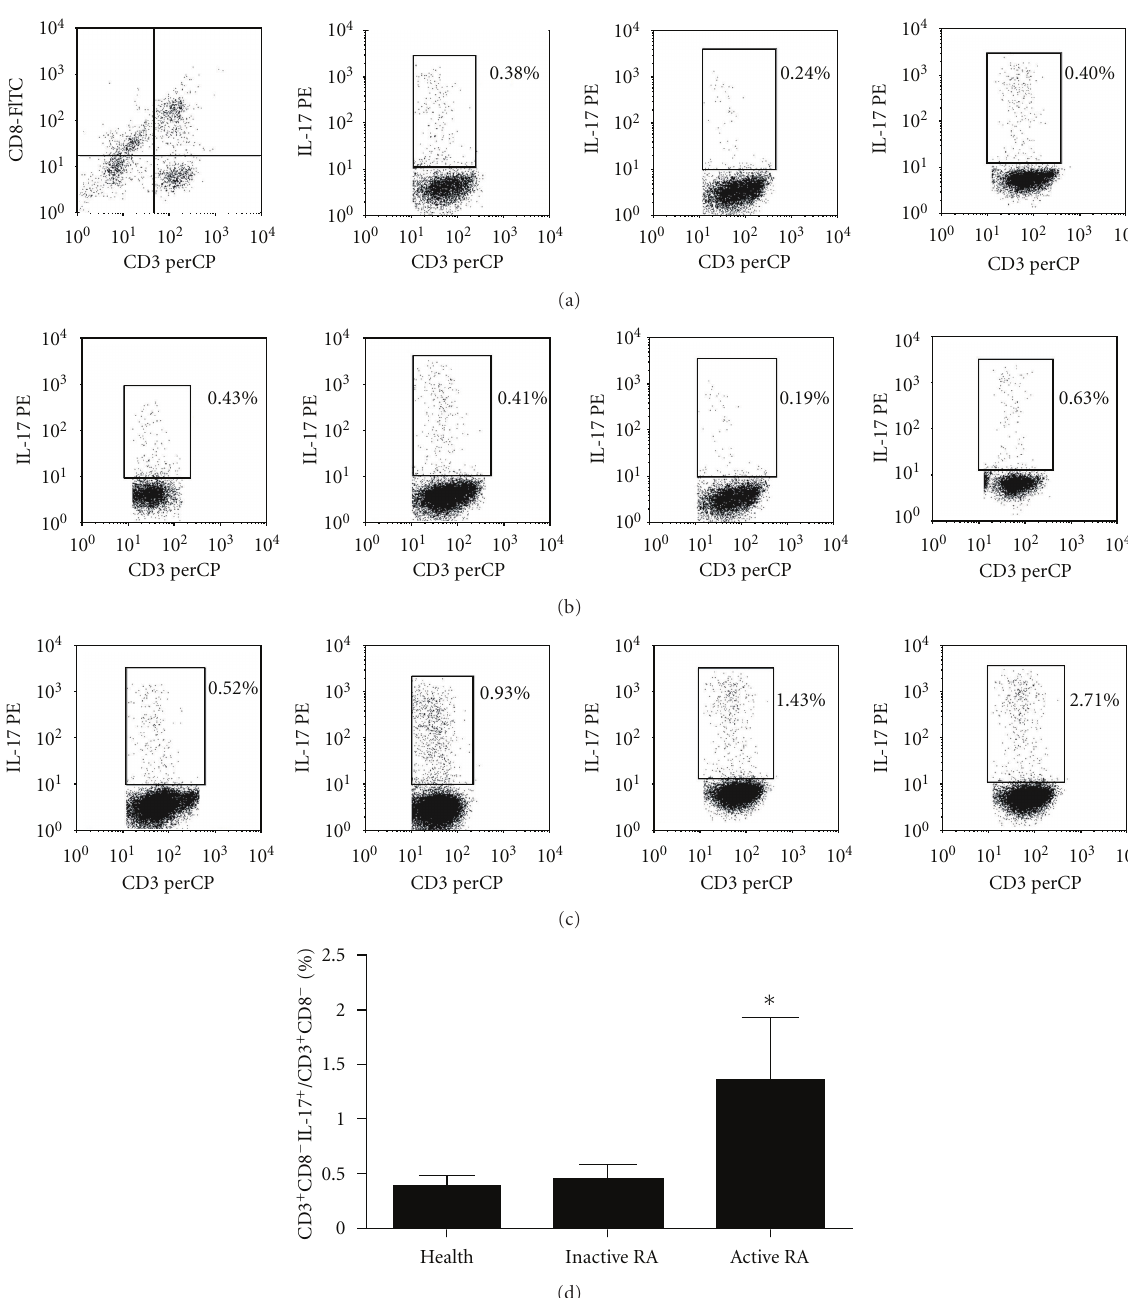
Neither the same source protein nor the endotoxin LPS had the function. We revealed that HMGB1-triggered the RA may via the Th17 pathway in RA